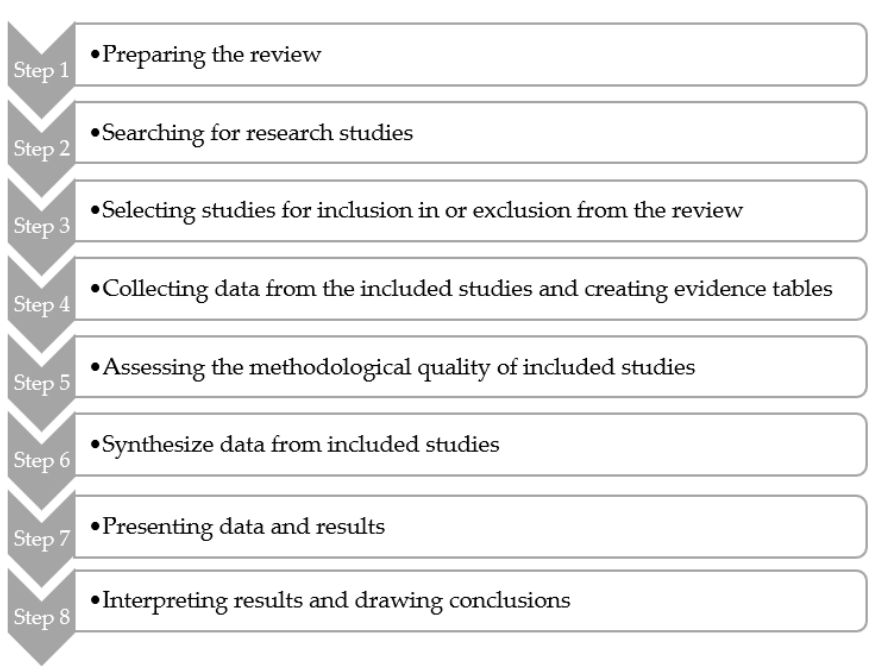
Figure 1. Core steps for performing a systematic review (adapted from the Cochrane Handbook for Systematic Reviews of Interventions, Higgins and Green (editors), 2009, and from the EFSA Guid- ance for those carrying out systematic reviews ( EFSA Journal , 2010;